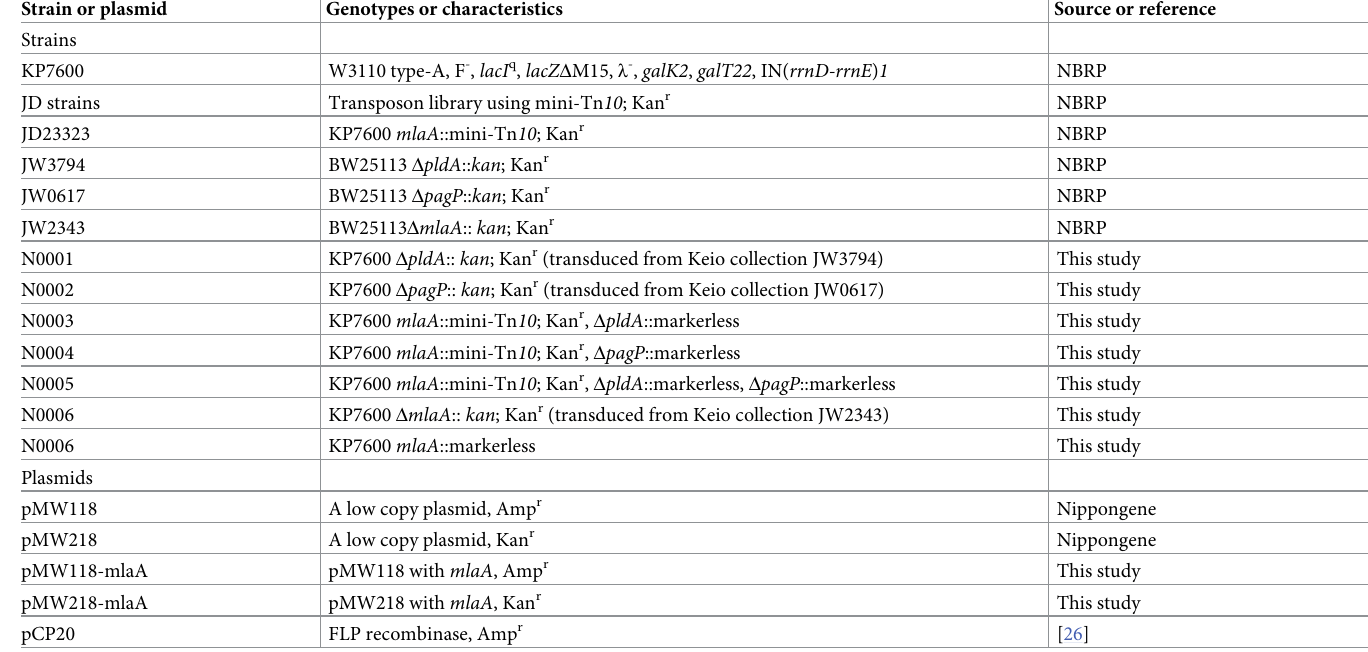
Table 2. List of bacterial strains and plasmids used. Strain or